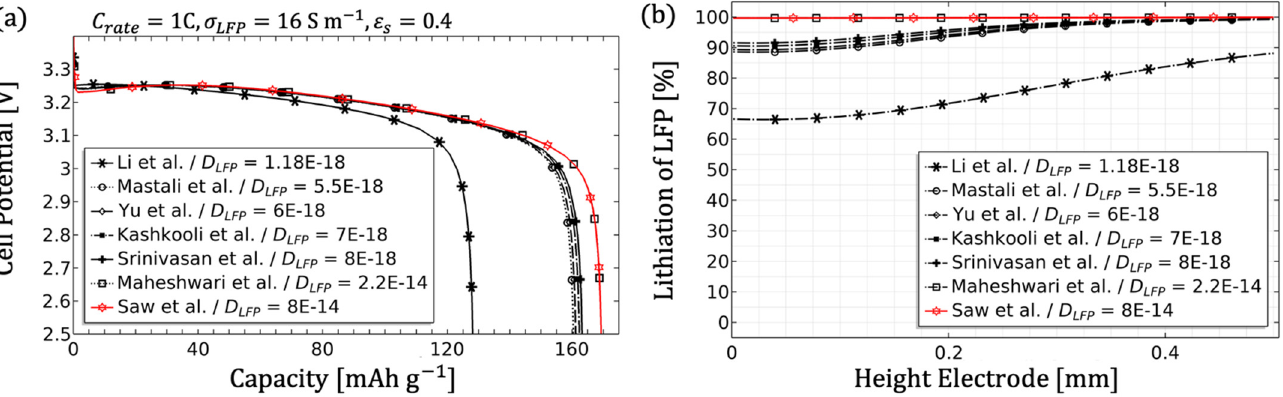
Figure 5. Parameter variation of the LFP electrode diffusion prefactor. The discharge performance at 1C with an optimised ε s = 0.4 and σ LFP = 16 S m − 1 is depicted in ( a ), and the lithiation along the electrode height at an DoD = 1 is shown in ( b ).